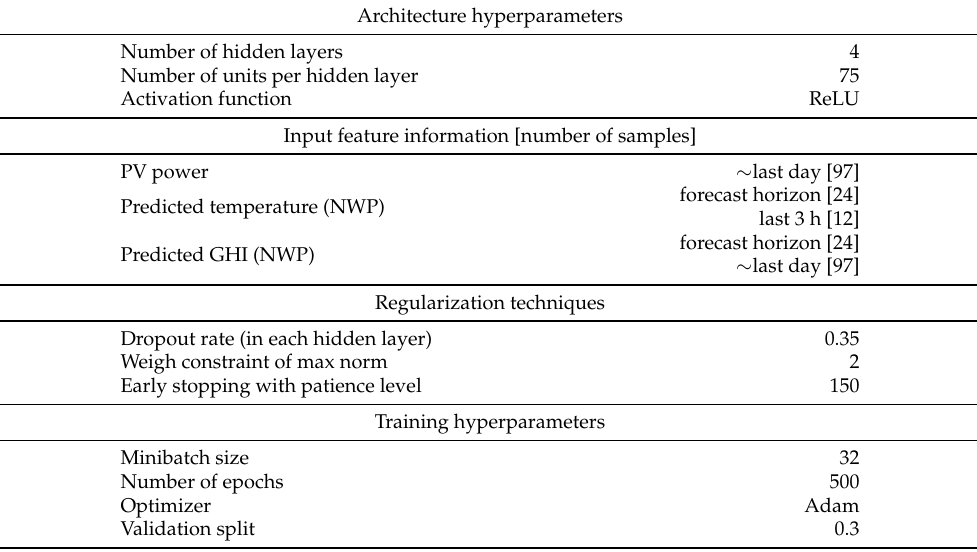
Table 2. Summarized information of training- and MDN